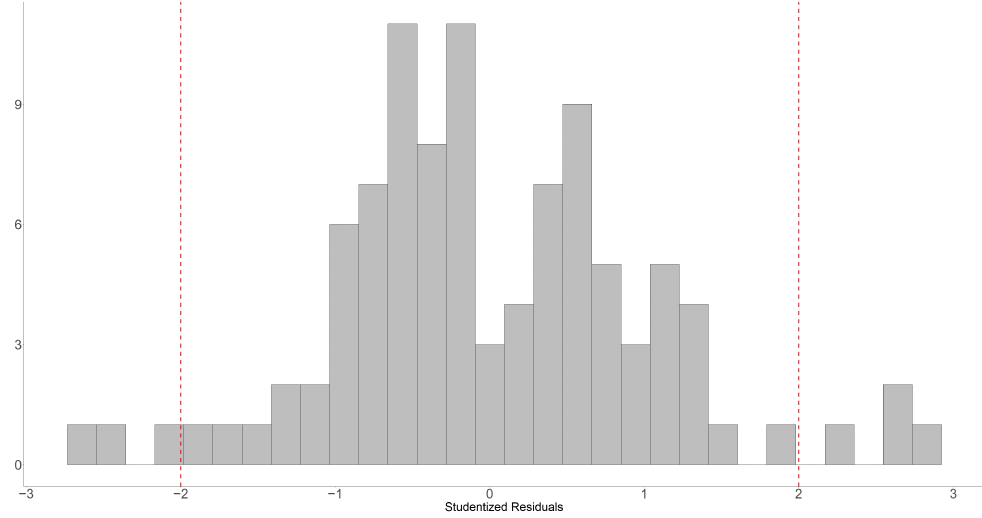
Figure 9. Studentized residuals for model